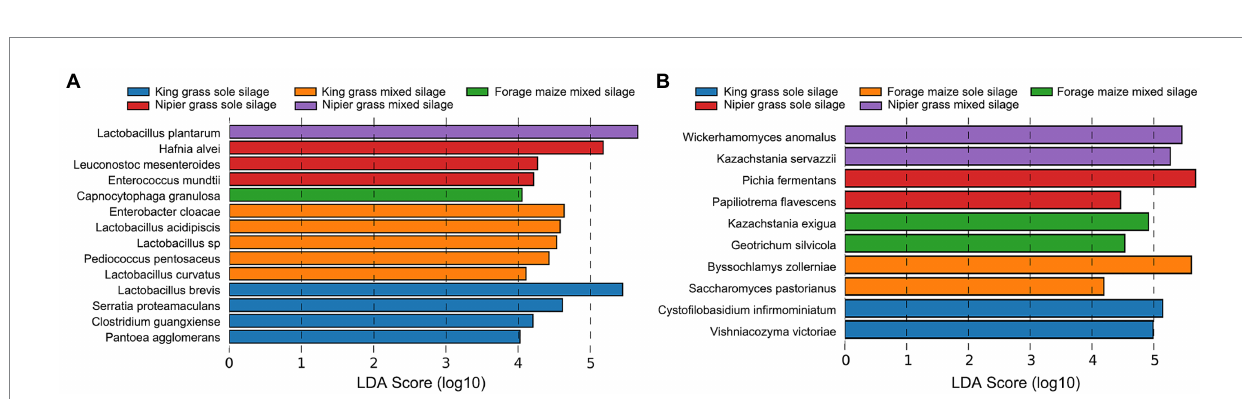
FIGURE 4 Graphics of linear discriminant analysis (LDA) effect size (LEfSe) of the biomarker prediction profiles between samples. The threshold on the logarithmic LDA score for discriminative features was set to 5.0 at an FDR-adjusted p -value <